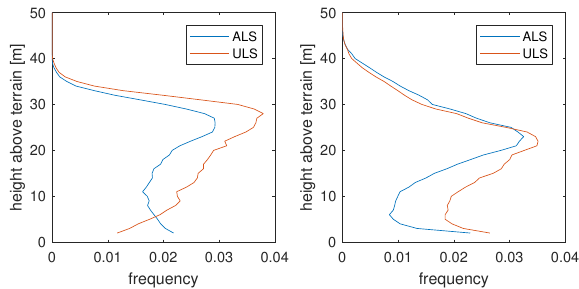
Figure 2. Comparison of point frequencies depending on height from ALS and ULS data for site 1 (left) and site 2 (right). The frequencies are measured in 1 m height intervals and state the fraction of points with regard to the total number of points per point cloud. As the bottom most layer contains the